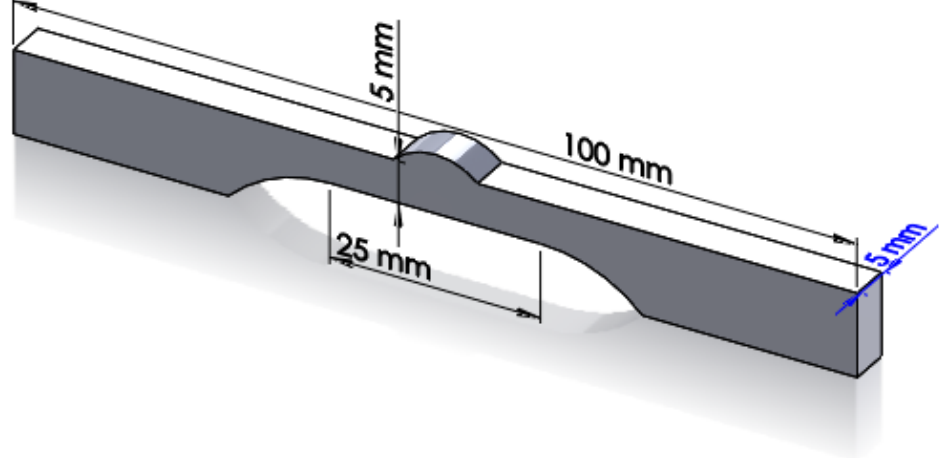
Figure 3. Schematic of the tensile and fatigue test specimen obtained from the welded plates.